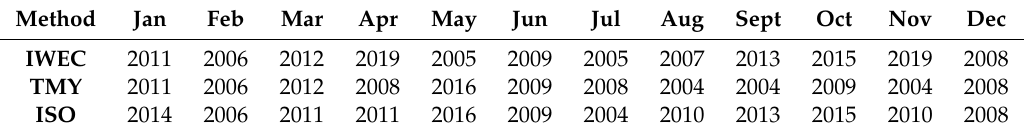
Table 6. Selection of the typical months according to the di ff erent